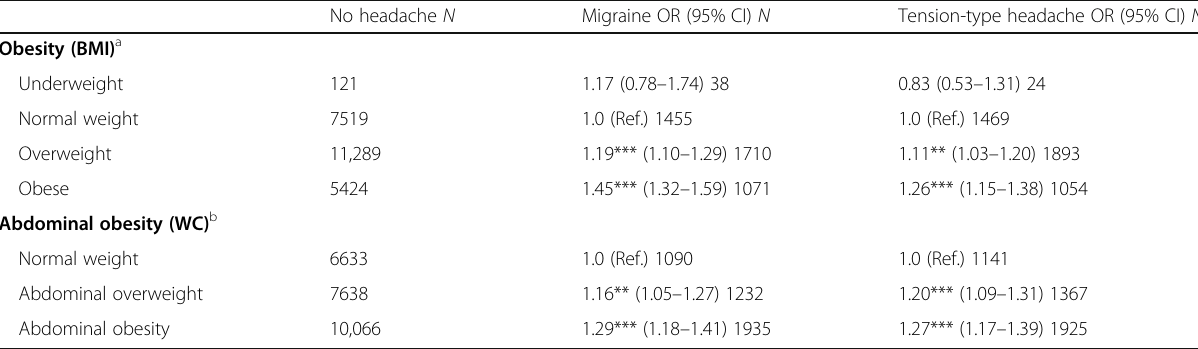
Table 2 Association between obesity and